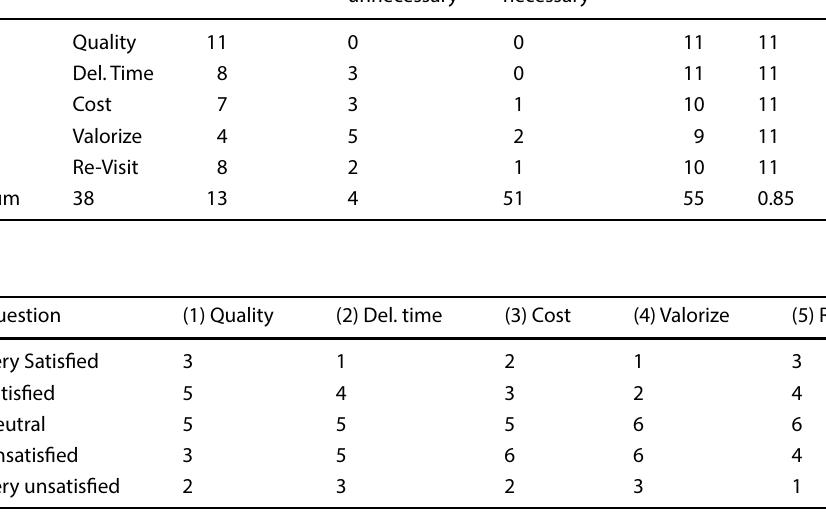
Table 2 Results of validity measurement of the